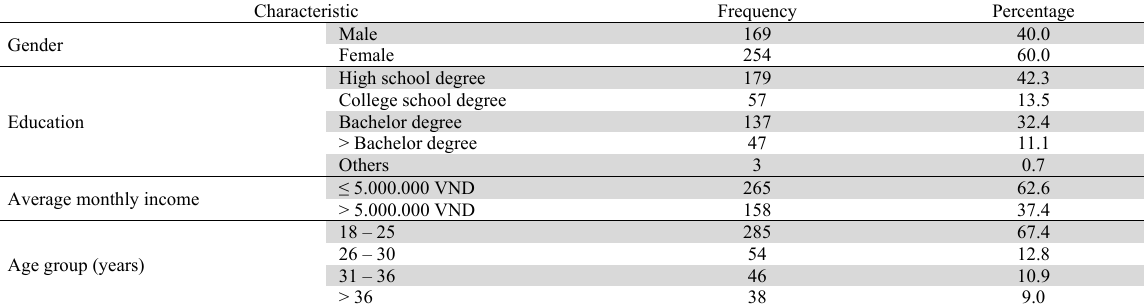
Demographics of the sample (n =